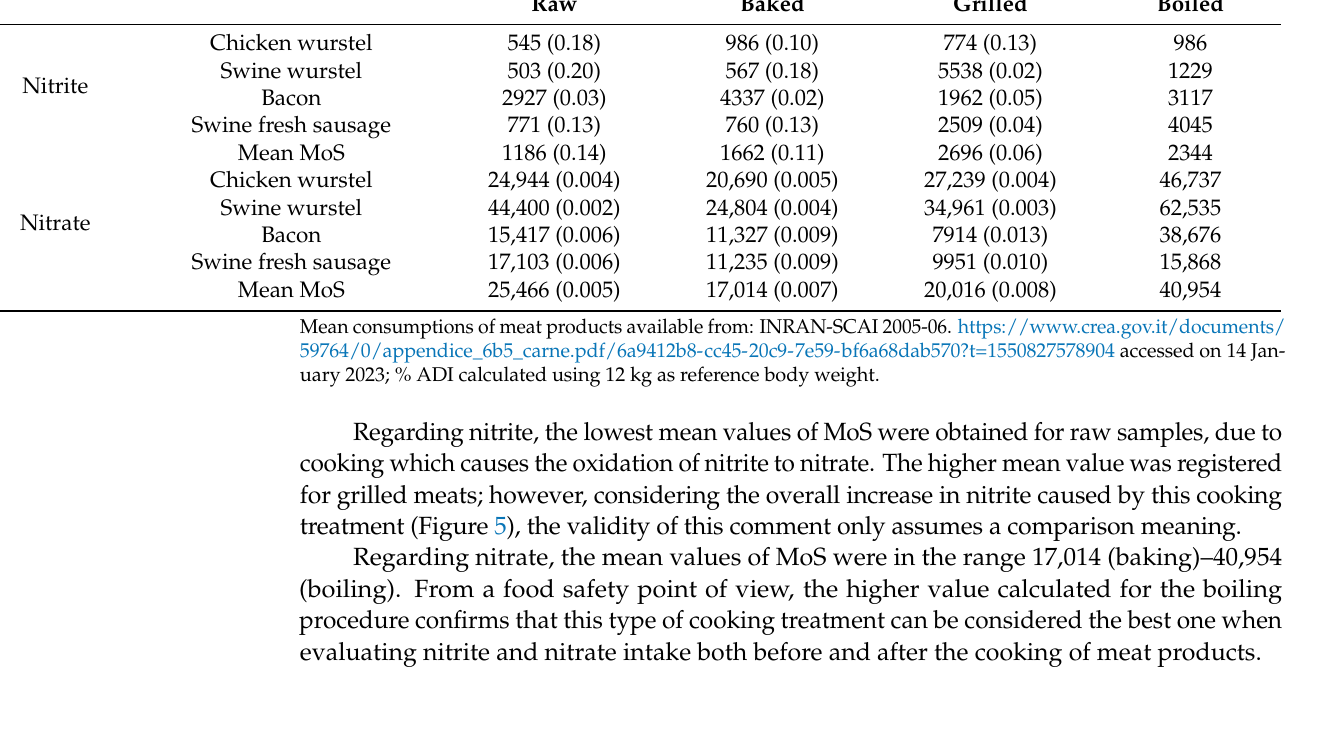
Table 3. Margin of Safety (MoS) for meat products both before and after cooking (in brackets: ADI%). Raw Baked